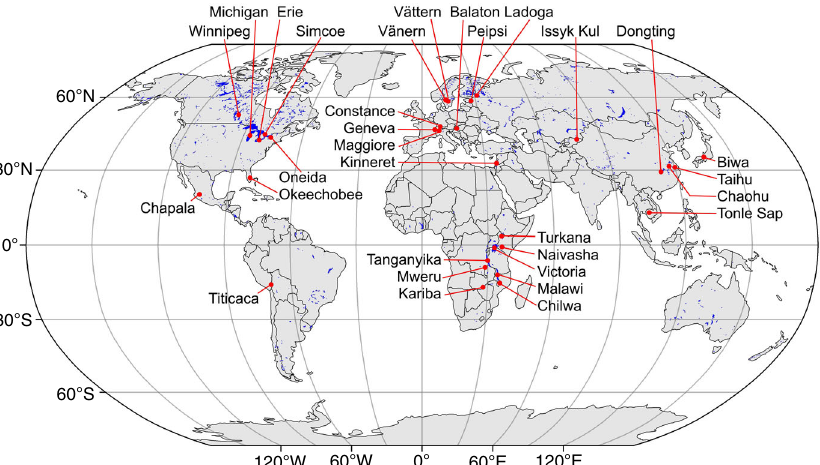
Fig. 1 Global distribution of the 31 study lakes. The map was generated by using R 58 and the R package rworldmap 62 to plot the centers of study lakes (as given in Supplementary Data 2) on a base world map, of which layers, including country borders, continent outlines, global lakes, and latitude – longitude grids, were obtained from a public domain map dataset Natural Earth